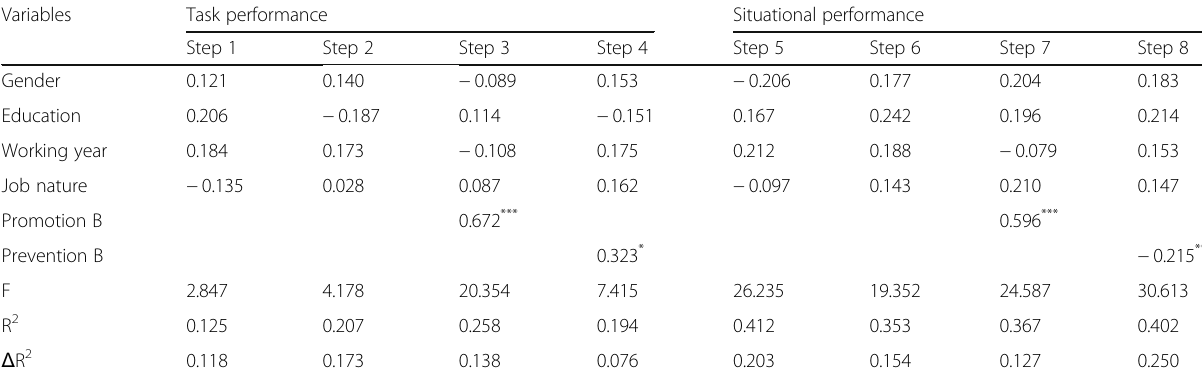
Table 2 Impact of promotion and prevention behavior on job performance Variables